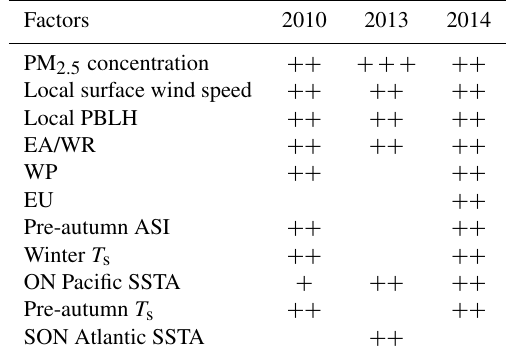
Figure 11. Mean of PM 2 . 5 concentration in winter at Shangdianzi Station from 2004 to 2014 as measured by the TEOM (solid) and β -ray (dash) method, and at Baolian Station from 2008 to 2014. The error bar represents 1 standard error among the different measured hours. Table 2. Summary of the various influence factors for WHD NCP . The “ +++ ” indicates “more important”, “ ++ ” indicates “impor- tant”, “ + ” indicates “less important” , and blank indicates “not im-